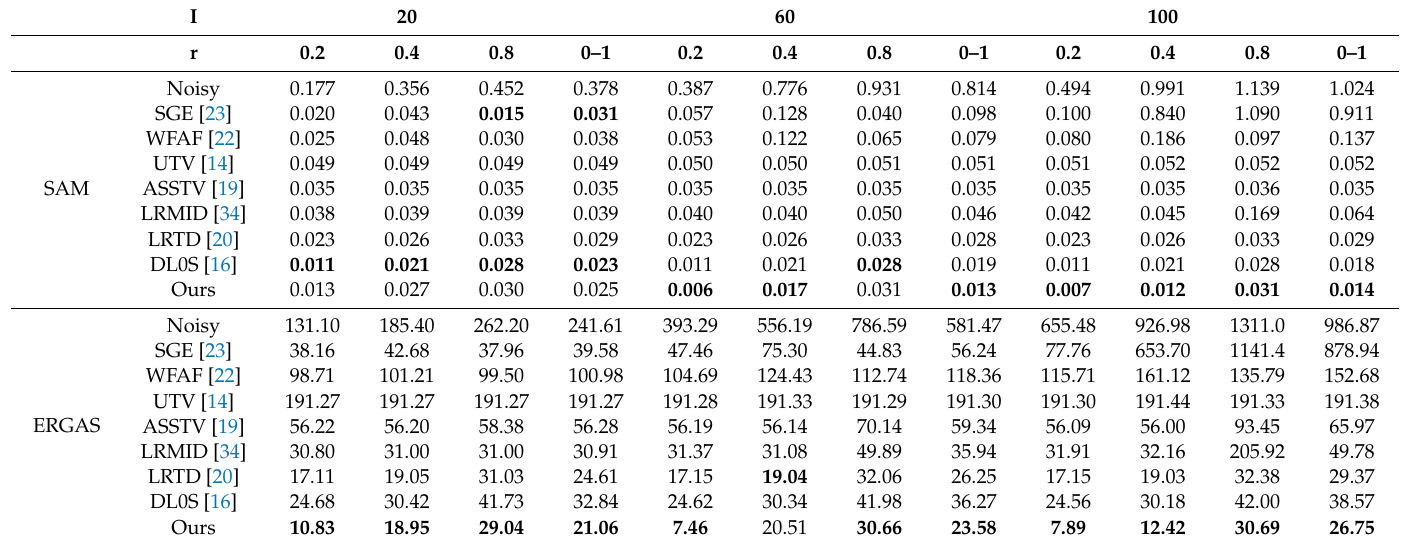
The boldface digits in Table 2 represent the best results.